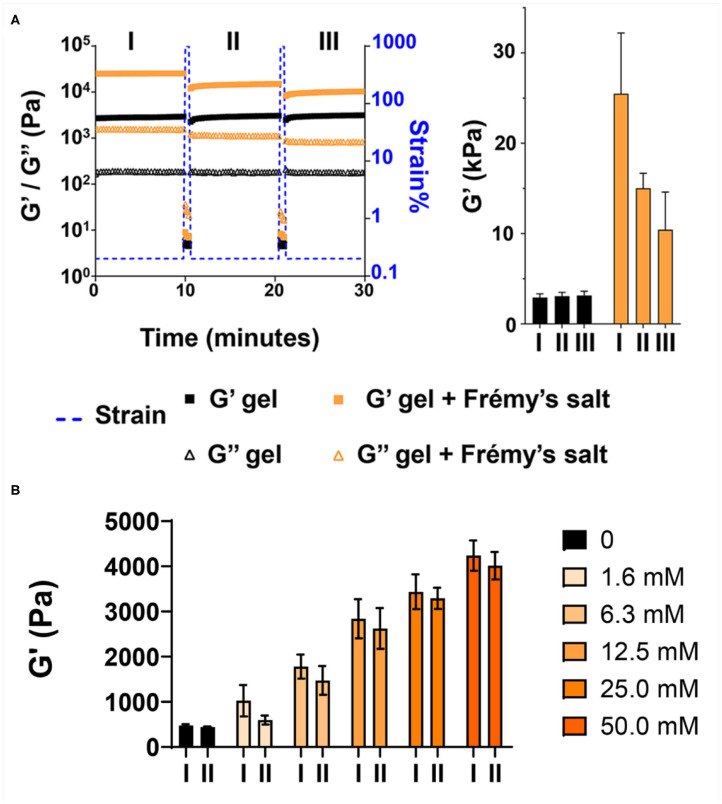
Frémy's salt increases the rigidity of tyrosine-functionalized gels. (A) Rheological characterization of 1 wt% gels after overnight incubation with or without Frémy's salt. Gels were subjected to repetitive shear-thinning cycles. In each cycle the storage (G′) and loss (G″) modulus of the gels were monitored as follows: 10 min of measurements within the linear viscoelastic regime (LVE, 0.2% strain, 6 rad/s), then 30 s under high strain that rupture the gel network (1,000% strain, 6 rad/s), following by 10 min measurements of the G′/G″ again within the LVE regime (0.2% strain, 6 rad/s) where the gel recovers. The bar graph at right displays G′ values obtained at the end of each 10 min measurement (marked as I, II, III). (B) Rheological characterization of 0.5 wt% gels after overnight incubation with different concentrations of Frémy's salt. Bar graph marked as I displays G′ values obtained at the end of the first 10 min measurement. Bar graph marked as II, displays recovery G′ values of the gels obtained 10 min after applying high strain (1,000%) to thin the gel network.